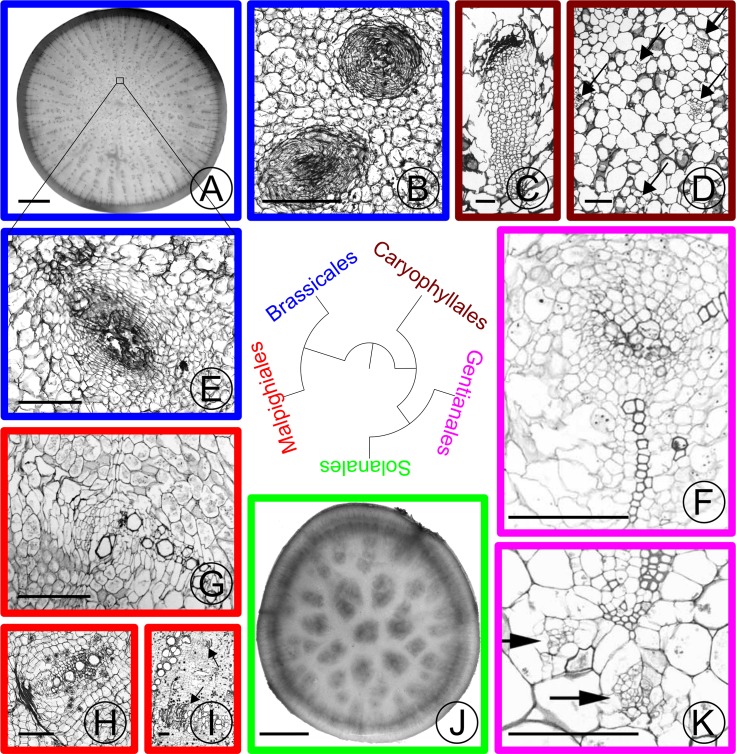
Stem and hypocotyl / root vascular bundles in parenchymatous tissues of various eudicot taxa.Taxonomic orders are colored based on the label in the phylogeny. (A) Turnip (Brassica rapa rapa) cross section. Small dots in the center of the section are supplemental vascular bundles (SVBs). (B) Close-up of medullary SVB in the stem of kohlrabi (Brassica oleracea gongylodes cv. ‘Purple Vienna’). A small zone of xylem encircles crushed phloem in the amphivasal bundle arrangement. (C) Close-up of old medullary SVB from the trunk of Trichocereus chilensis (Cactaceae) showing a long tail of xylem adjacent to phloem that is capped with crushed secondary phloem (dark band). (D) Cross section of young stem just below the shoot apical meristem of Subpilocereus ottoni (Cactaceae) showing the distribution of five medullary bundles (arrows). (E) Close-up of SVB of turnip from boxed region in (A), showing the same arrangement of vascular tissues as kohlrabi. (F) Older medullary SVB from stem of Pachypodium namaquanum (Apocynaceae) with two zones of xylem and a zone of phloem interior to the xylem. (G) Old collateral medullary SVB from stem of Adenia keramanthus (Passifloraceae). (H) Old collateral SVB from root tuber of A. inermis. (I) Large collateral medullary SVBs from stem of A. metamorpha. (J) Cross section through tuberous root of Ipomoea batatas (Convolvulaceae). Dark regions in the center of the root are zones of proliferation with SVBs. (K) Medullary bundles from Caralluma burchardii (Apocynaceae) with two medullary phloem bundles (arrows) below protoxylem. Scale: (A), (J) 10mm; (B)-(I),(K): 250 m. (C) and (D) adapted from [4] with permission from the author; (F) and (K) adapted from [5] with permission from the author.